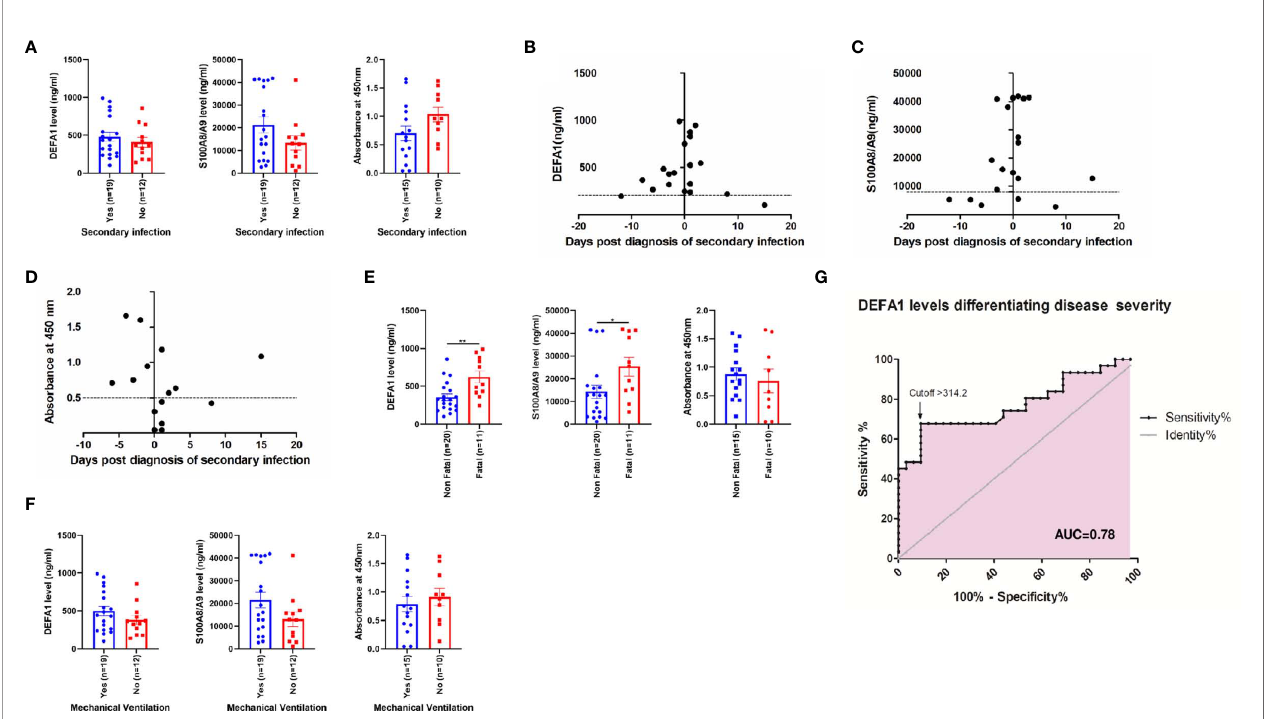
FIGURE 3 | Expression levels of neutrophil activated proteins in severe COVID-19 patients in relation to occurrence of secondary infection and mechanical ventilation. Figure (A) depict comparative levels of DEFA1, S100A8/A9 and MPO in severe patients with or without secondary infection. The data is presented as dot plots with bar representing the mean ± SEM in each group. Each dot represents a single sample. P values were calculated using Mann-Whitney test. Figures (B – D) depicts levels of (B) DEFA1, (C) S100A8/A9 and (D) MPO on different days before or after diagnosis of secondary infection. Each dot represents a single sample. The dotted line indicates cut-off value calculated as average value of expression levels of neutrophil activated proteins in healthy controls + 2*standard deviation. Comparative levels of DEFA1, S100A8/A9 and MPO among severe disease patients with (E) non-fatal and fatal disease outcome and (F) requiring mechanical ventilation. The data is presented as dot plots with bar representing the mean ± SEM in each group. Each dot represents a single sample. P values were calculated using Mann-Whitney test. * denotes p-value < 0.05, ** denotes p-value < 0.01. (G) Receiver-operator characteristics (ROC) curve of DEFA1 serum levels for the prediction of COVID-19 disease severity among mild and severe disease